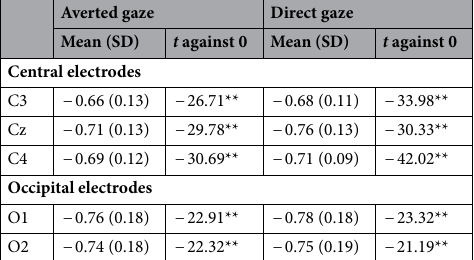
Table 1. Mean central mu and occipital alpha suppression (in 8–13 Hz frequency band) for each gaze condition and electrode. ** p < 0.001.